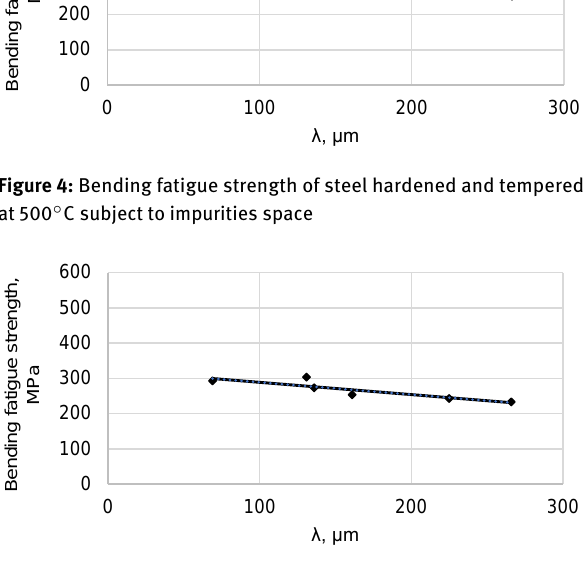
Figure 5: Bending fatigue strength of steel hardened and tempered at 600 ∘ C subject to impurities space